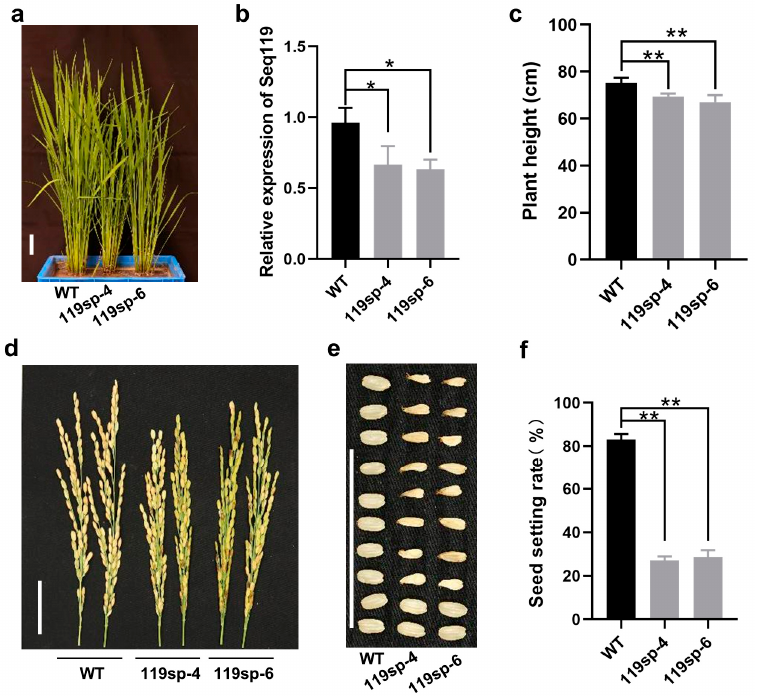
Figure 3. Suppression of Seq119 in rice plants: ( a ) Two lines of plants expressing the target mimic of Seq119 (119sp-4, 119sp-6). ( b ) Results of qRT-PCR showing the relative expression levels of Seq119 in plants (*, p < 0.05). ( c ) Heights of 119sp-4 and 119sp-6 plants (**, p < 0.01). ( d , e ) Panicles ( d ) and seeds ( e ) of WT plants and 119sp-4 and 119sp-6 plants. ( f ) Seed setting rates of WT plants and 119sp-4 and 119sp-6 plants (**, p < 0.01). Bars, 4 cm. Values are means ± SD. Student’s t test was used to test the significance of the difference.